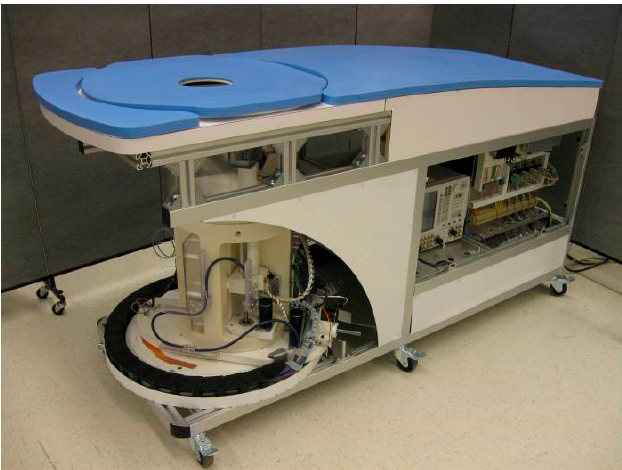
Figure 1. View of the patient compatible monostatic radar system with adaptive sensor placement capability (image source: Sensors 2017, 17, 1658).